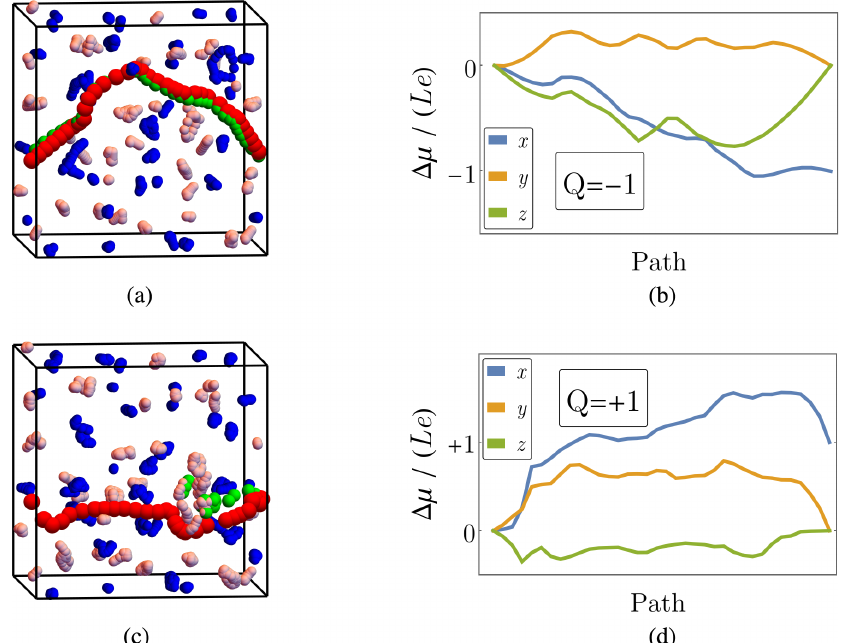
FIG. 6. (a),(c) Different loops in the K 33 Cl 31 atomic configuration space, whose initial and final configurations are the same. Cl atoms are depicted in blue. All K atoms but one are depicted in pink. One selected K atom, depicted in red, is moved from its initial position to its periodic image along the x direction, thus featuring a winding number n ix ¼ þ 1 . All the other atoms feature zero winding numbers. The position of the lone pair is depicted in green. (b),(d) Dipoles displaced along the closed paths depicted on their left. The charge displaced along the two paths differ, in spite of the displacement of the same K atom and the same winding numbers. This difference indicates that no oxidation state can be uniquely associated to the (arbitrarily) chosen K atom, and transport anomalies have to be